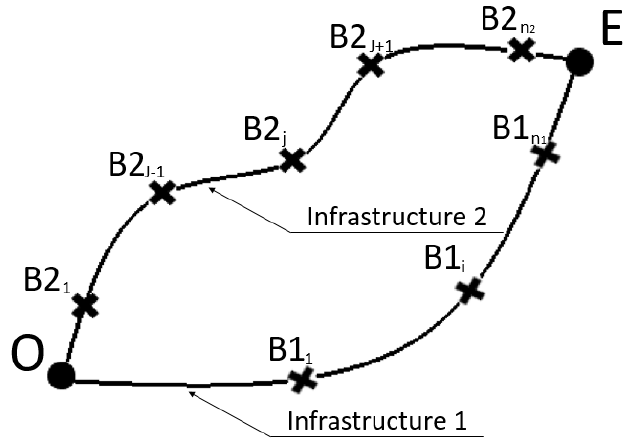
Figure 2. Scheme of the road infrastructures considered in the case